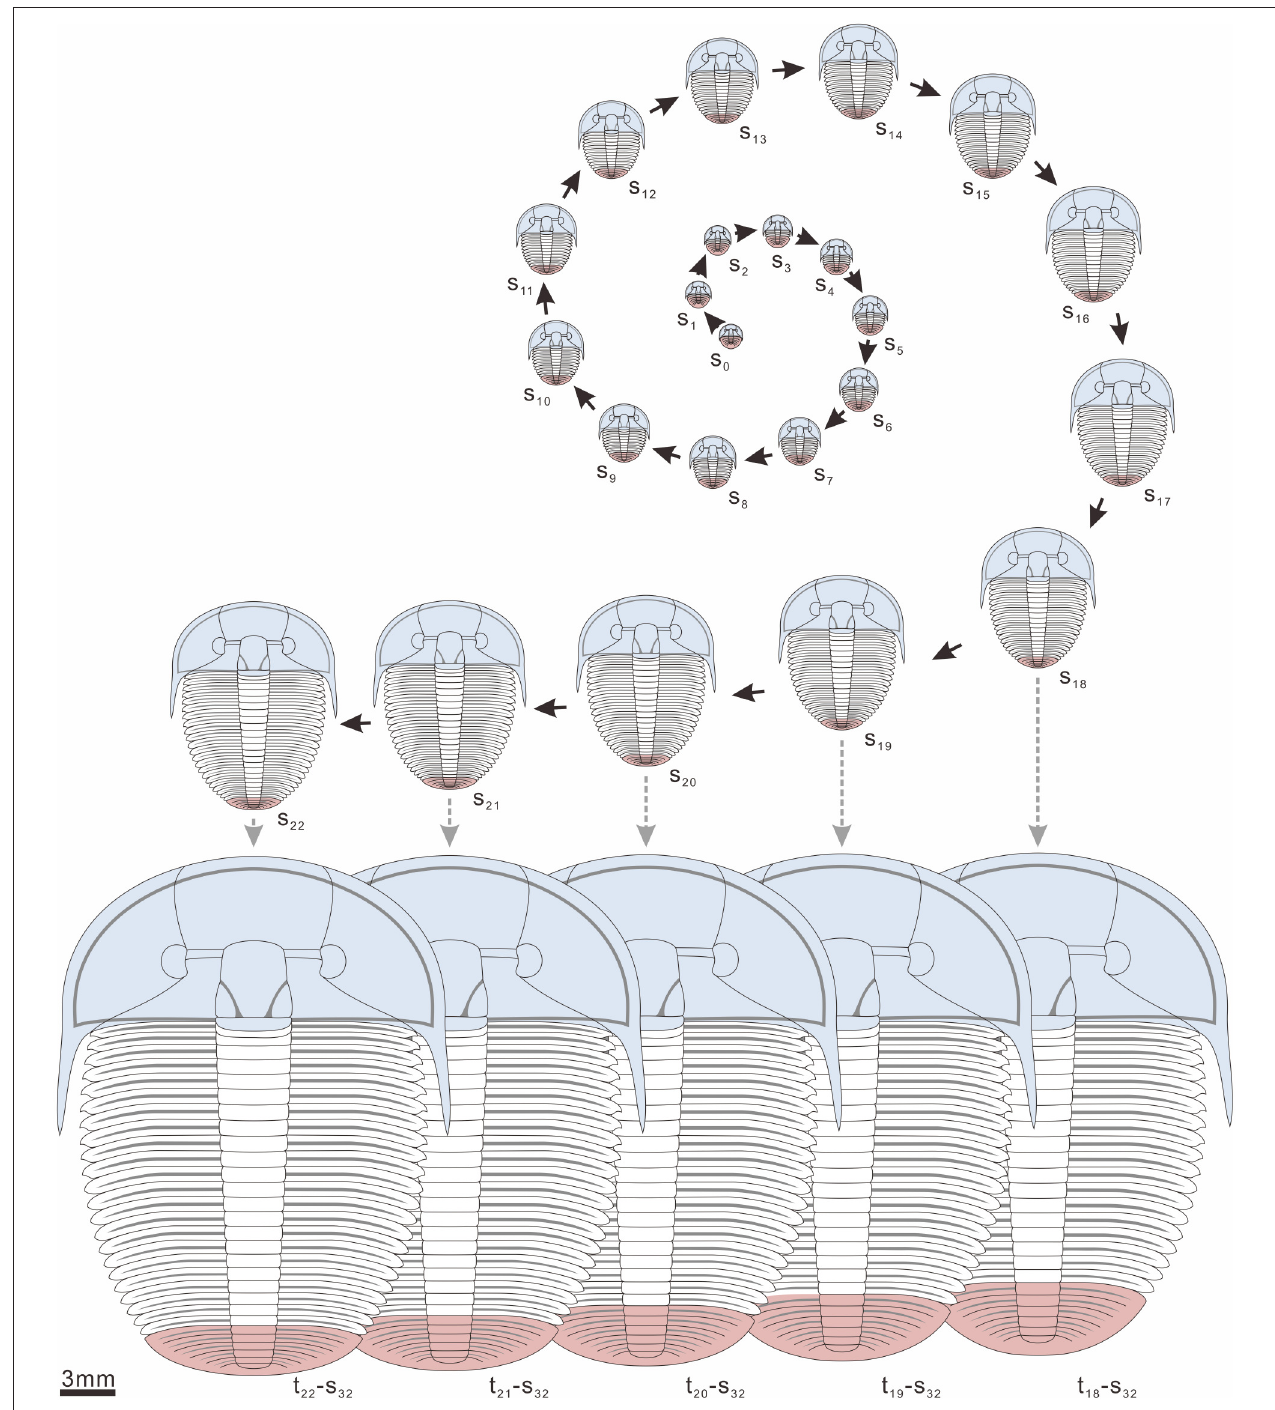
FIGURE 4 | Meraspid and holaspid ontogeny of the five morphotypes of A. koninckii . Meraspid ontogeny of the five morphotypes extended through a different number of stages, from s 0 –s 17 for morphotype t 18 , to s 0 –s 21 for morphotype t 22 . All stages are shown at the same scale with respect to body length. (i) as specimens of the different morphotypes entered the holaspid period at a different stage (from s 18 for t 18 , to s 22 for t 22 ) and trunk length growth rate was higher during meraspid period than in the holaspid period, at stage s 32 morphotypes with more thoracic segments tended to have longer trunks than the morphotypes with less thoracic segments, as a consequence of a prolonged meraspid period; (ii) as specimens of the different morphotypes terminated thoracic segment release at a different stage (from s 18 for t 18 , to s 22 for t 22 ) and thoracic segment release had the effect of shortening the relative length of the pygidium (overwhelming the larger growth rate of the pygidium due to the growth gradient), at stage s 32 morphotypes with more thoracic segments tended to have relatively shorter pygidia than the morphotypes with less thoracic segments, as a consequence of more prolonged thoracic segment release.